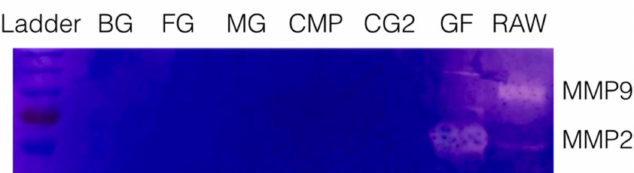
Figure 2. Zymography of the supernatant of collagen